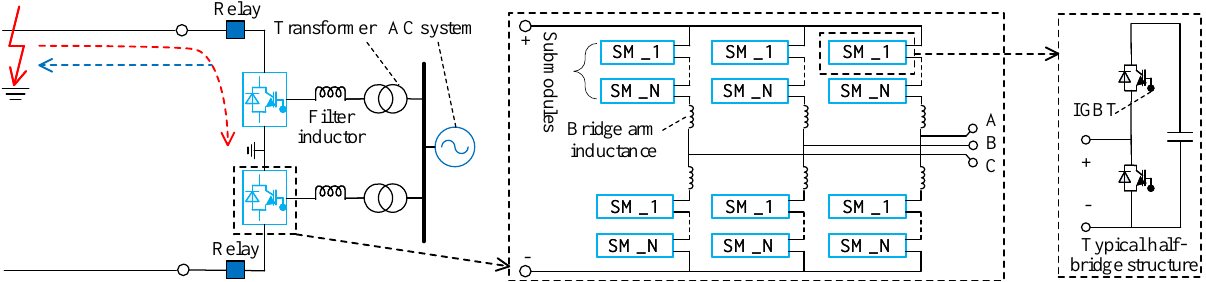
Figure 3. Typical structure of MMC-HVDC inverter station.